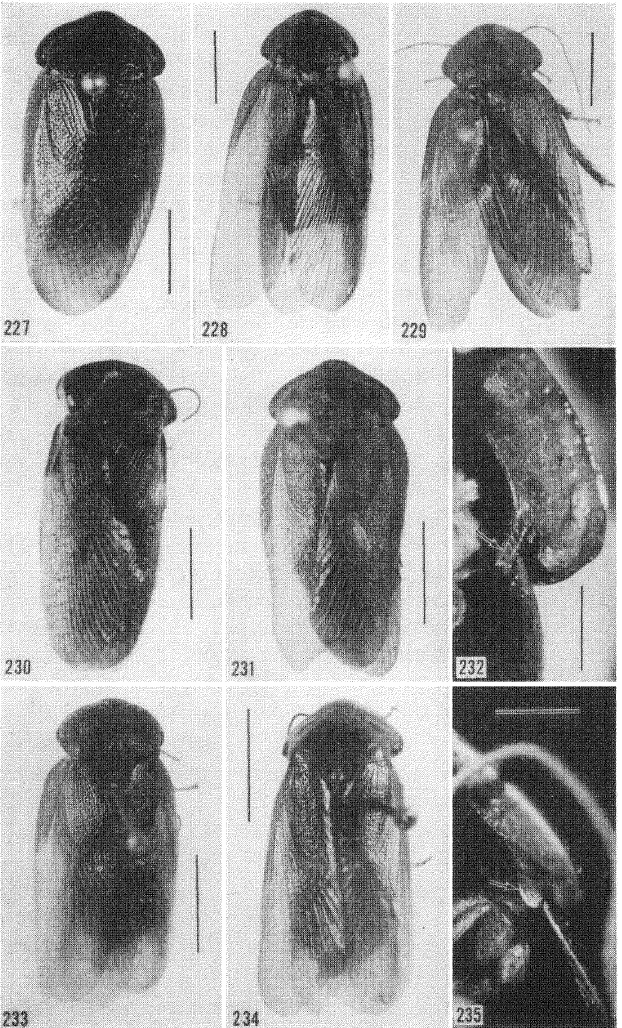
Figures 227-235. Adult males of Perisphaerus spp. 227. (176 ANSP). P. contiguus (Sauss.). Mr. Lamington, N.E. Papua (det. Hebard). 228. (39 CUZM). P. flaicornis Burm. Java. 229. (983 L). P. aterrimus (Herbst). Kangean Island, Oengkokop (de.t. Princis). 230. P. semilunatus (Hanitsch). Sakaerat, Khorat Province, Tha.iland (det. Princis). 231-232. (104 MCZ). P. glomeri[ormis Lucas. Samar, Catarman, Philippine Islands (det. Princis). 232. Tooth (arrow) on underside of pronotum. 233-235. P. armadillo Ser- ville. 233. (989 L). Prai Jawang, East Sumba (det. Princis). 234-235. (109 MCZ). Zamboanga, Philippine Islands (det. Princis). 235. Tooth (arrow) on underside .of pronotum. (scale: Figs. 232, 235---1 mm; all others 5